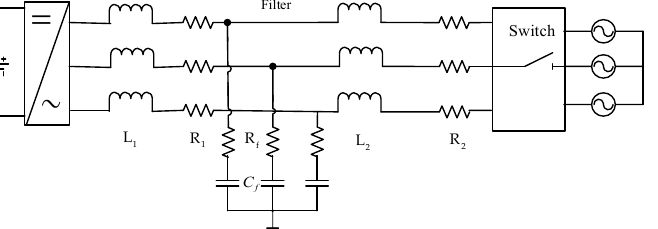
Figure 6. Configuration filter of a grid connected inverter with an inductor capacitor inductor.